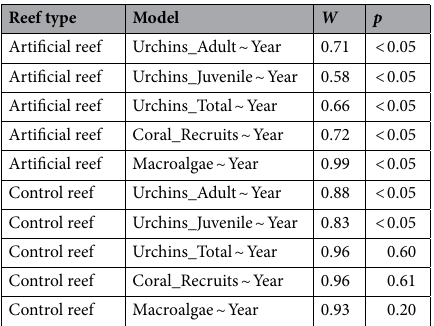
Table 1. Data were separated by reef type (artificial or control) and analysis of the residuals of each ecological variable by year was conducted using a Shapiro–Wilk test for normality. The residuals for most models were non-normally distributed, therefore a non-parametric approach was selected.